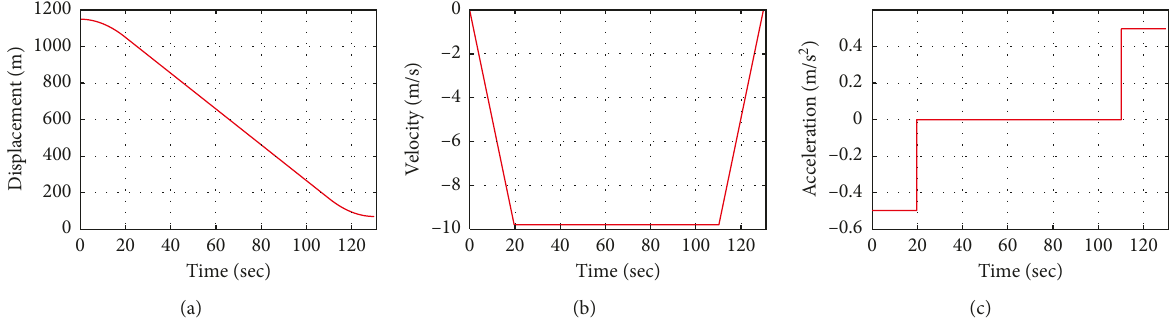
Figure 3: Conveyance movement profiles. The (a) displacement curve, (b) velocity curve, and (c) acceleration curve.